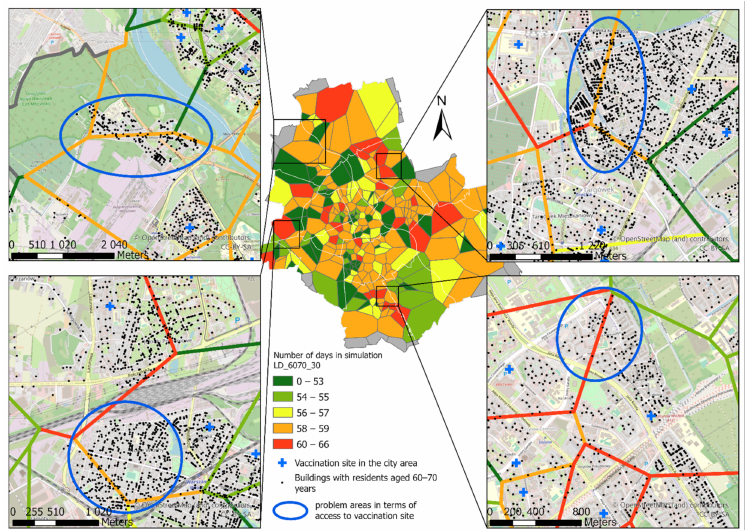
Figure 16. Example of identified areas characterised by low availability of COVID-19 vaccination sites for city residents aged